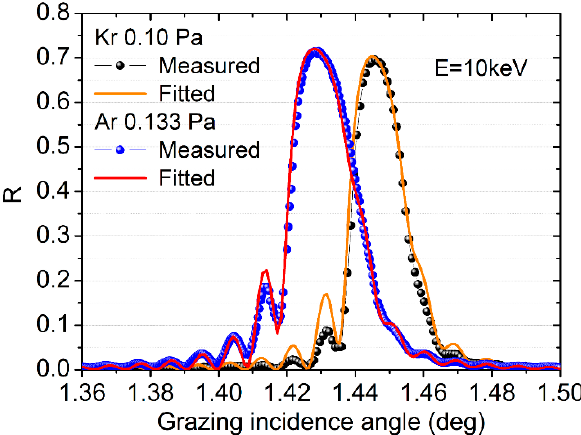
Figure 7. X-ray reflectance of the two multilayers with 150 bilayers measured in the Shanghai Synchrotron Radiation Facility (SSRF).